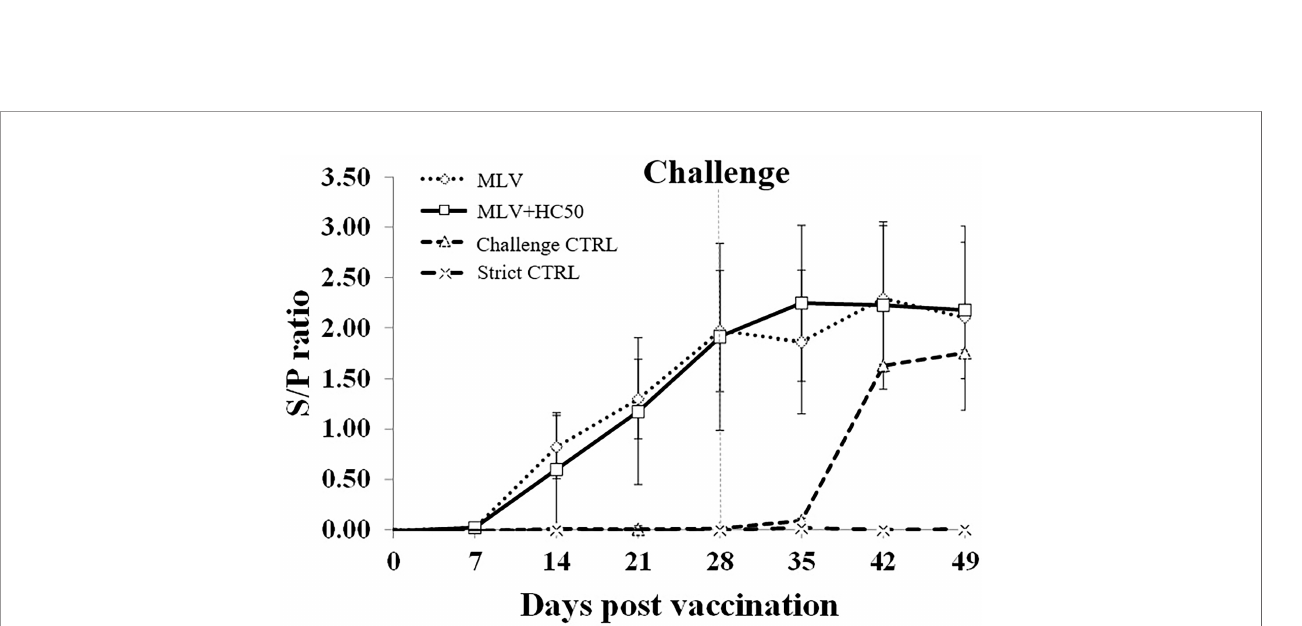
FIGURE 6 | PRRSV-speci fi c Ab response tested over time by ELISA. Pigs ( n = 6) were injected i.m. with Amervac ® PRRS MLV (0 dpv) (MLV) and Amervac ® PRRS MLV (0 dpv) and fed p.o. with HC50 (0 – 49 dpv) (MLV+HC50) or vaccine solvent used for resuspension of lyophilized Amervac ® PRRS MLV (0 dpv) (Challenge CTRL). The animals were challenged i.n. with HP-PRRSV-2 at 28 dpv (dotted vertical line). Strict control pigs (Strict CTRL) received no treatment. Sera were collected weekly from all pigs at 0 – 49 dpv. The positive Ab response was determined at an s/p ratio of 0.4 or higher. One-way repeated measures ANOVA, followed by Dunnett ’ s test was used to determine the signi fi cant difference in mean s/p ratios ( p < 0.05). Error bar indicates the